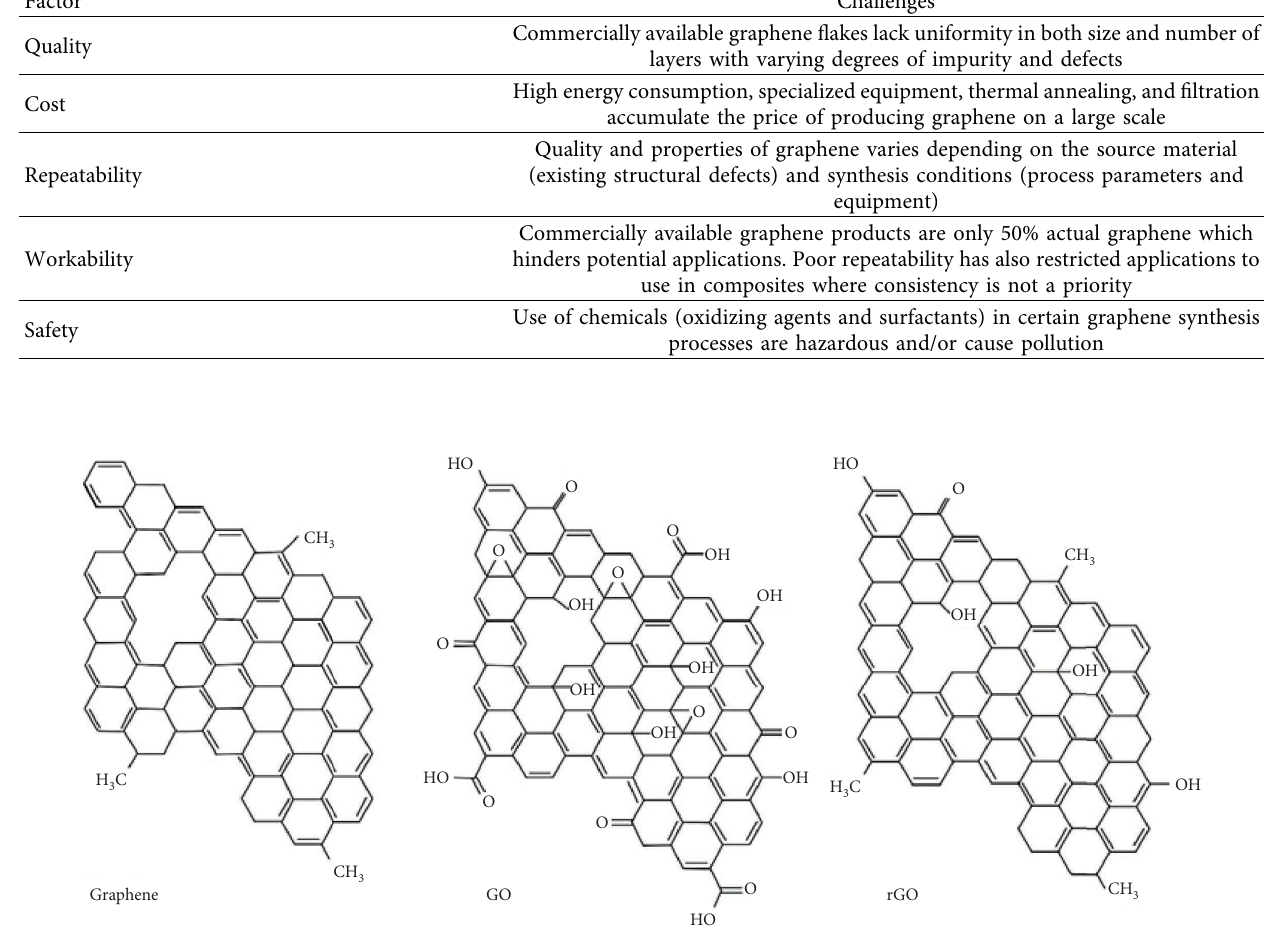
Figure 1: Structure of graphene, graphene oxide (GO), and reduced graphene oxide (rGO) [8].